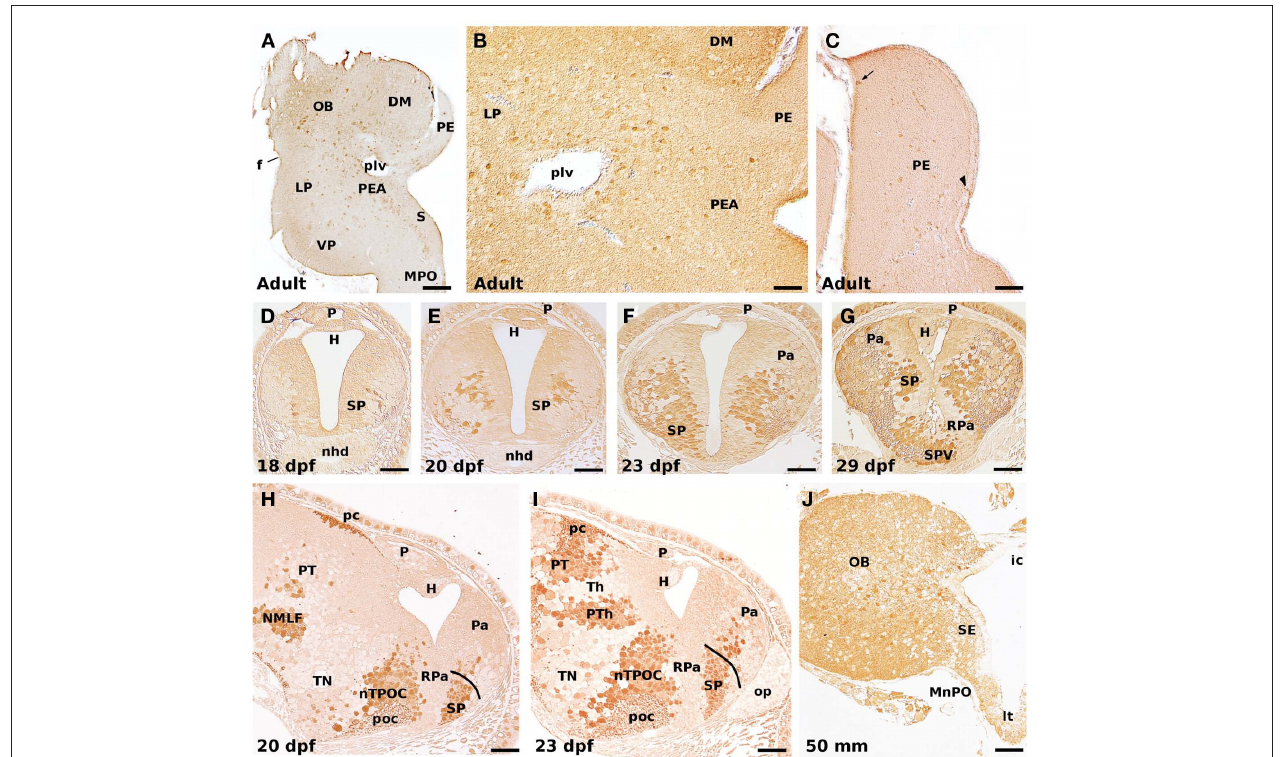
(H,i) , rostral is to the right. OB, olfactory bulb; DM, dorsomedial neuropile; f, fissura circularis; H, habenula; ic, interbulbar commissure; LP, lateral pallium; lt, lamina terminalis; MnPO, median preoptic nucleus; MPO, medial preoptic nucleus; nhd, nasohypophyseal duct; NMLF, nucleus of the medial longitudinal fascicle; nTPOC, nucleus of the tract of the postoptic commissure; op, olfactory placode; P, pineal organ; Pa, pallium; pc, posterior commissure; PE, prethalamic eminence; PEA, pallial extended amygdala; plv, posterior lateral ventricle; poc, postoptic commissure; PT, pretectum; PTh, prethalamus; RPa,